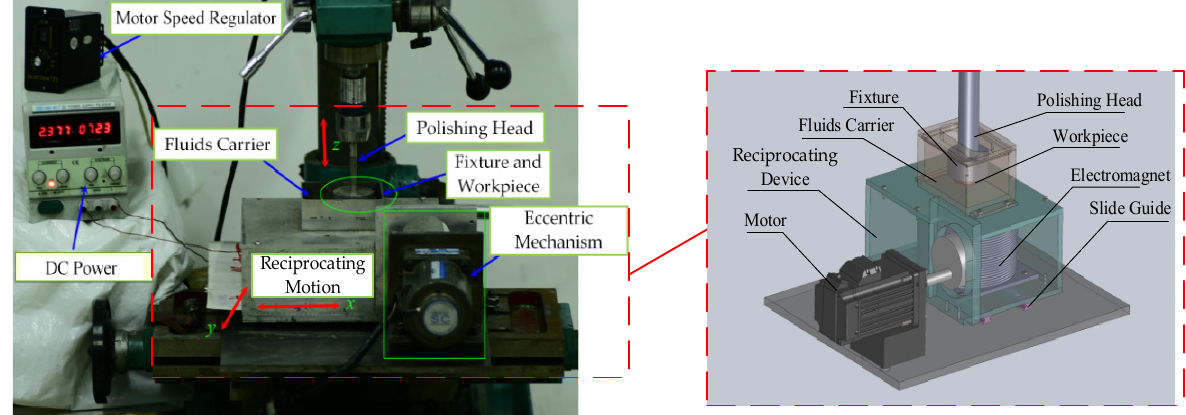
Figure 2. Experimental setup of the RMRP.